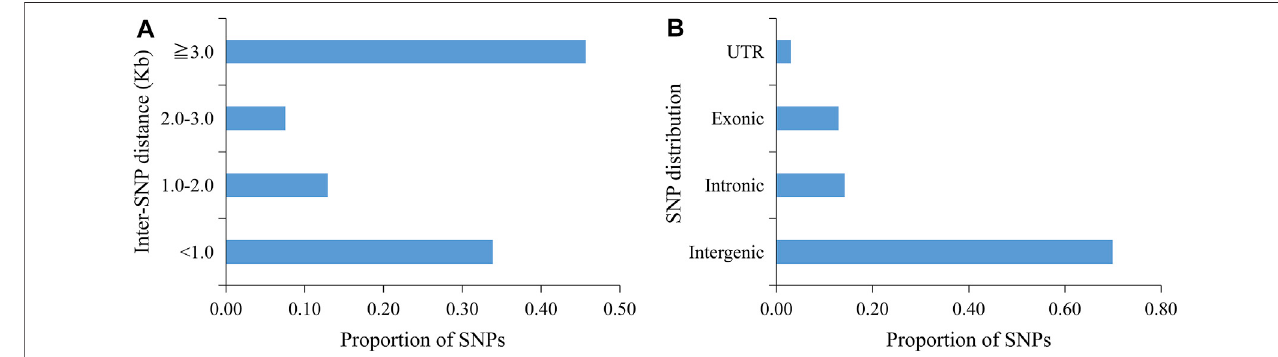
FIGURE 2 | Genome-wide SNP density and distribution of 37,929 SNPs. (A) Interval statistics between SNPs. (B) Illustration of the ratio of SNPs in the intergenic region and different positions in the gene region.